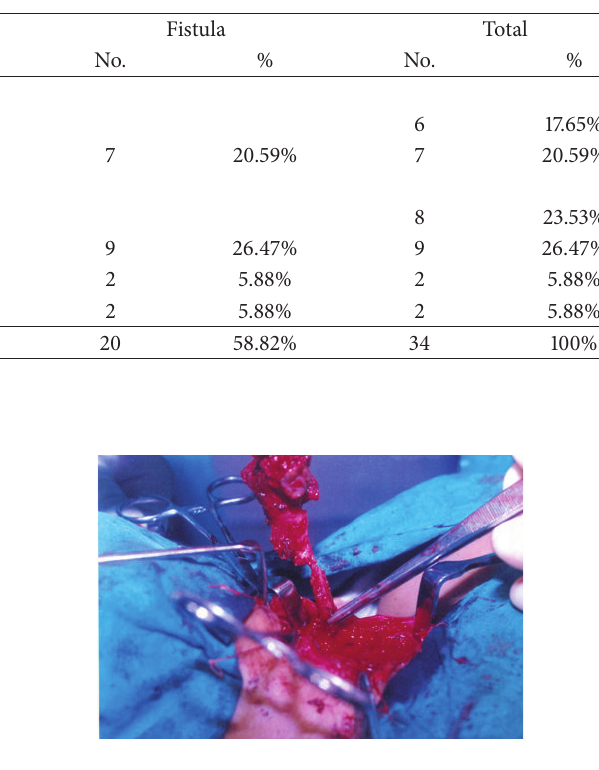
Figure 4: Excision of fourth branchial